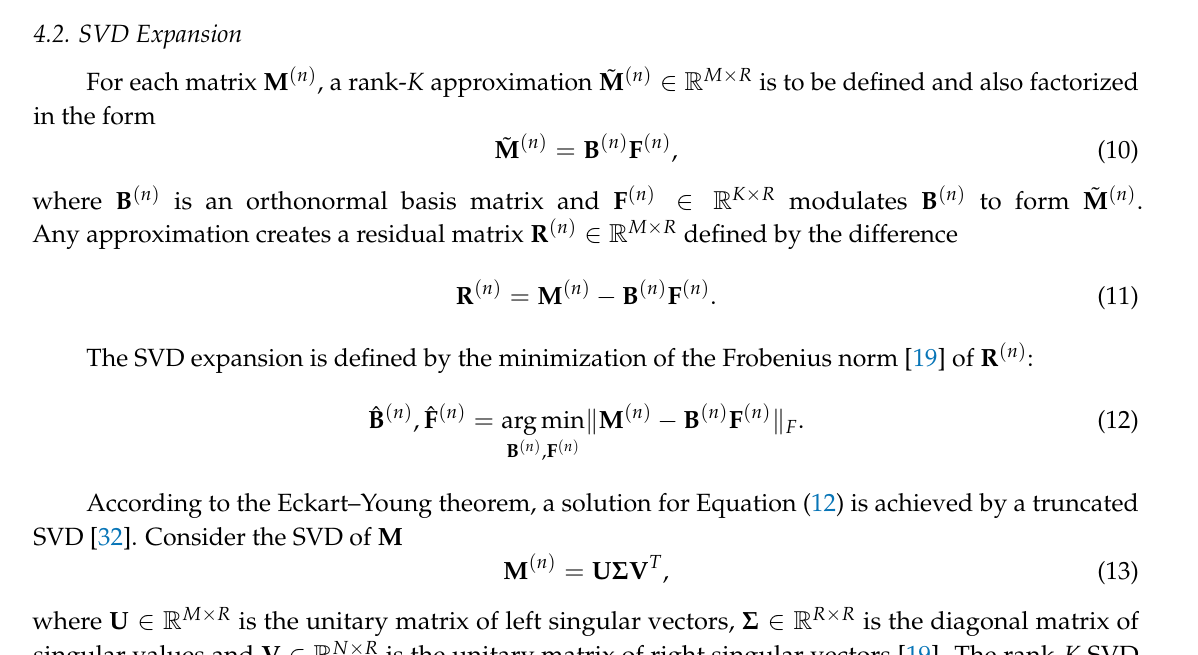
Figure 2d. The red dot corresponds to the data caused by the off-grid reflector from Figure